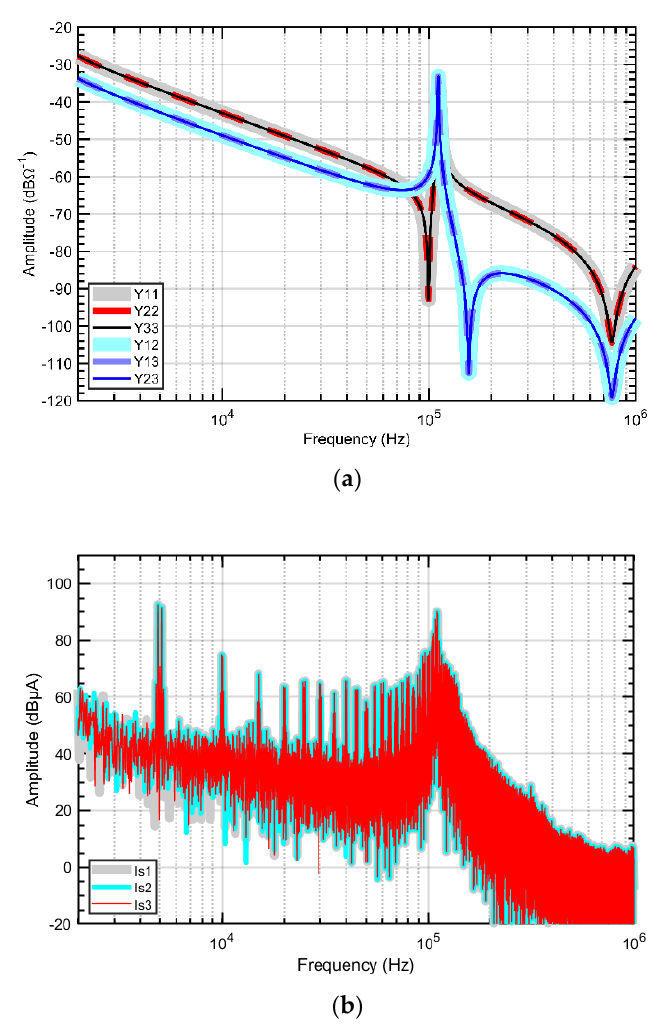
Figure 7. Extracted black-box model: ( a ) Selected six Y-parameter of DUT; ( b ) Three current sources.